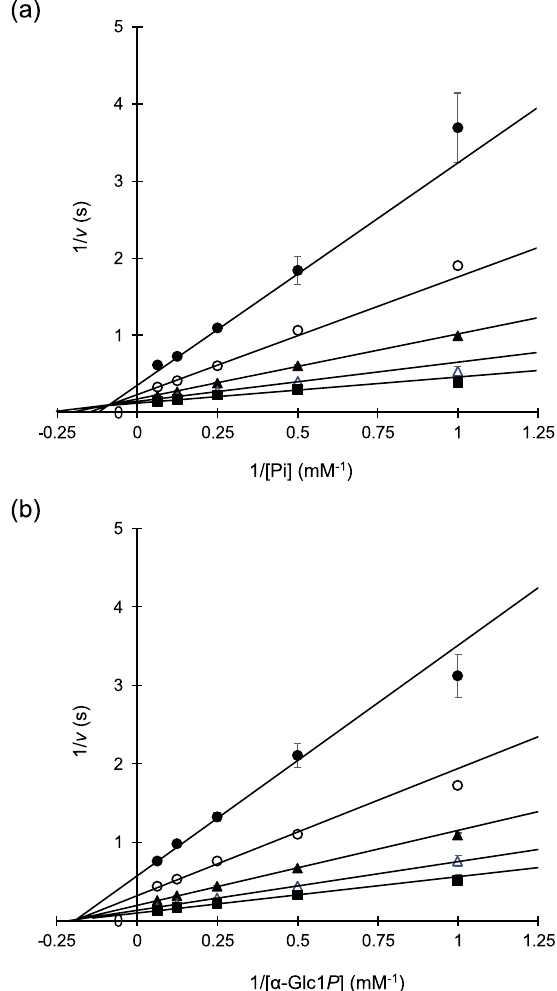
Figure 5. Double reciprocal plots for the phosphorolysis and synthesis of solabiose. (a) Phosphoroylsis of solabiose. Reaction rates at 1, 2, 4, 8, and 16 mM inorganic phosphate in the presence of 1 (filled circles), 2 (open circles), 4 (filled triangles), 8 (open triangles), and 16 mM solabiose (filled squares) are shown. (b) Synthesis of solabiose. Reaction rates at 1, 2, 4, 8, and 16 mM α-Glc1 P in the presence of 1 mM (filled circles), 2 mM (open circles), 4 mM (filled triangles), 8 mM (open triangles), and 16 mM d-galactose (filled squares) are shown. Average of three independent experimental values are plotted. Error bars indicate standard deviation of the